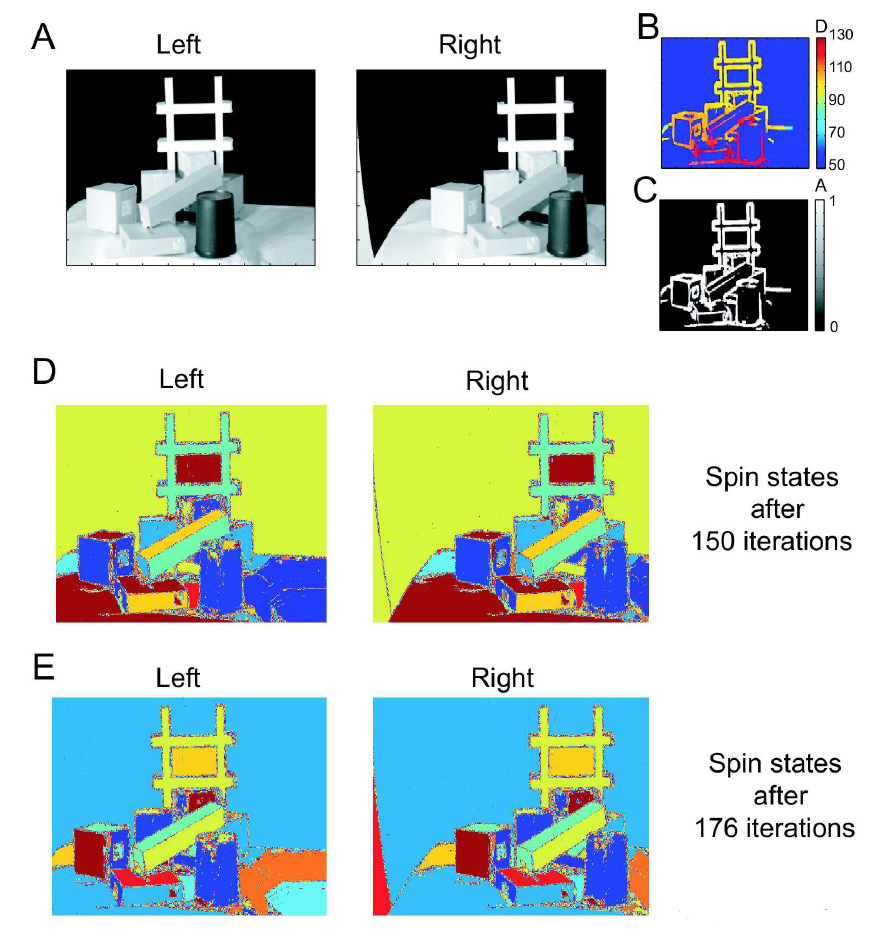
Figure 4. Cluttered-objects stereo pair. A Stereo image pair showing a cluttered scene containing a variety of objects. B-C The dense stereo algorithm returns mainly disparity information the edges of the objects. D-E The spin states computed by the clustering algorithm are shown after both 150 and 176 iterations for easier visual identification of the